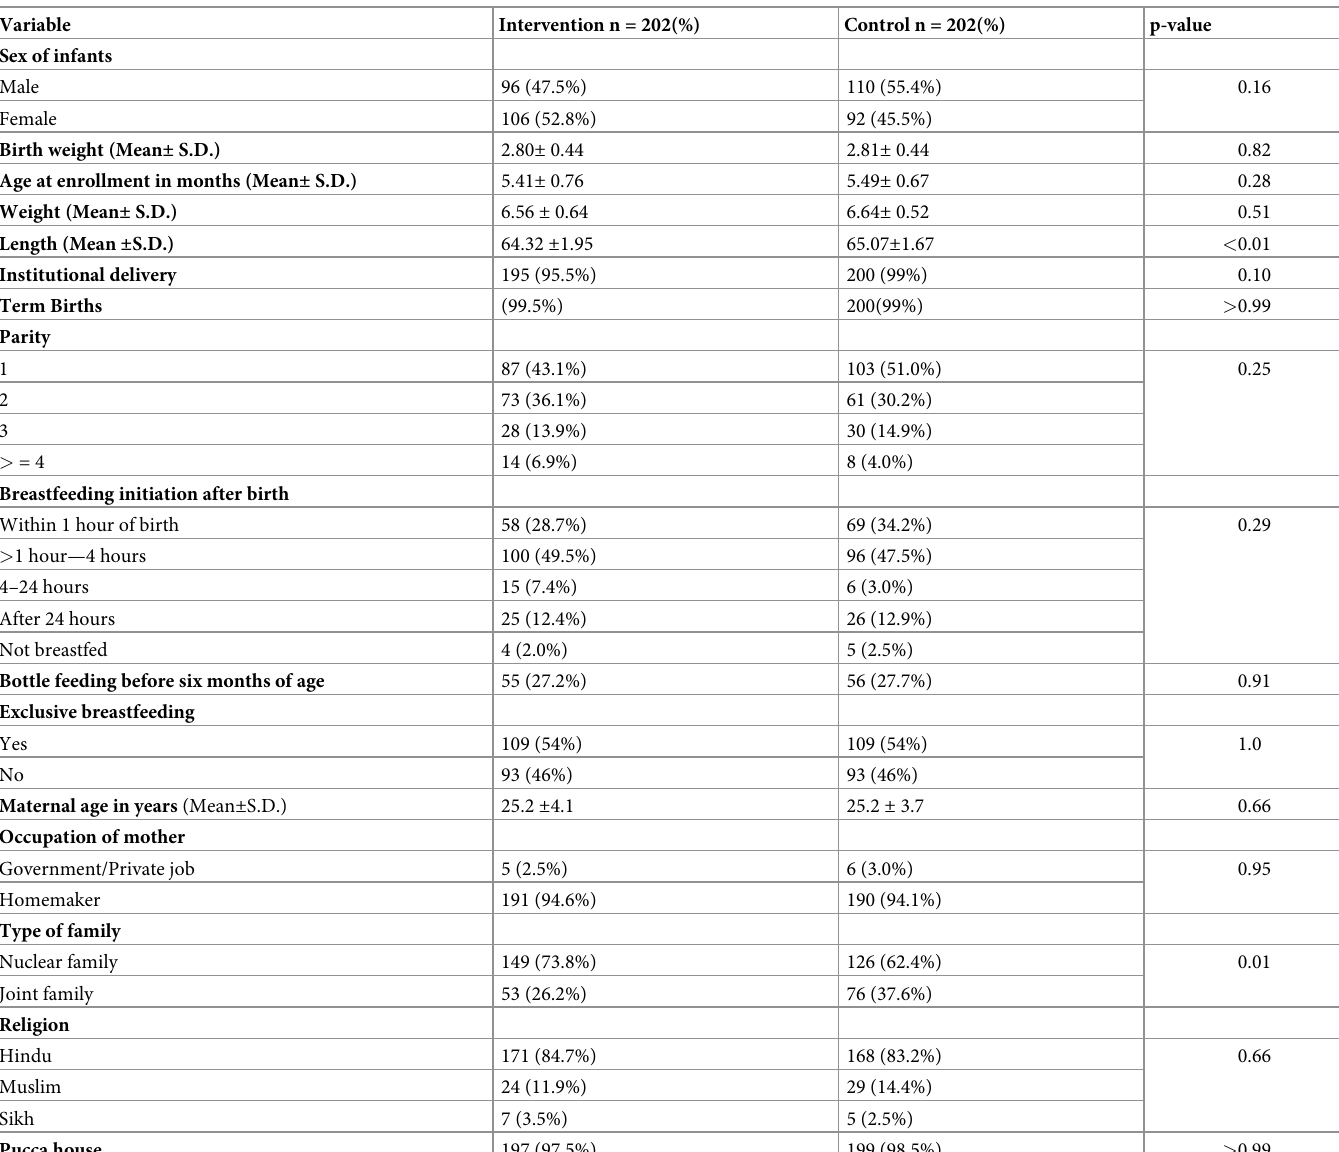
Table 1. Baseline characteristics of intervention and control